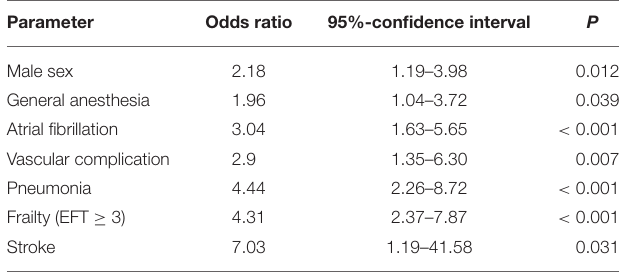
TABLE 2 | Predictors of postoperative delirium after